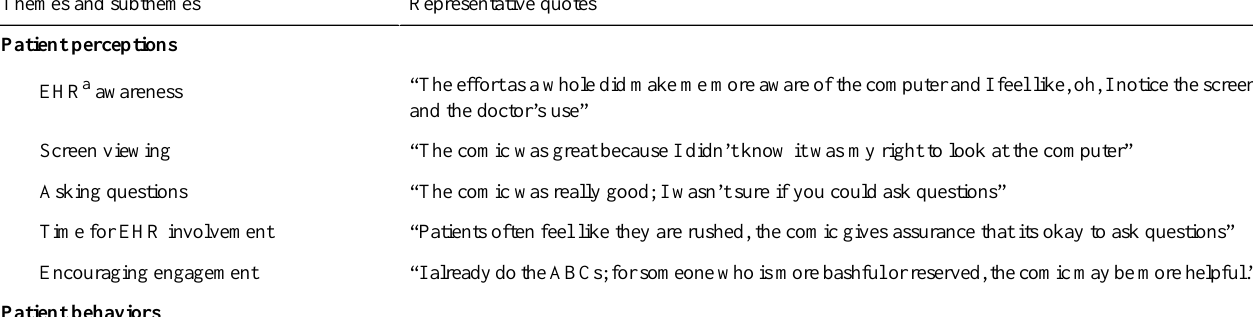
Table 4. Themes and subthemes relevant to the educational comic and EHR use. Patient